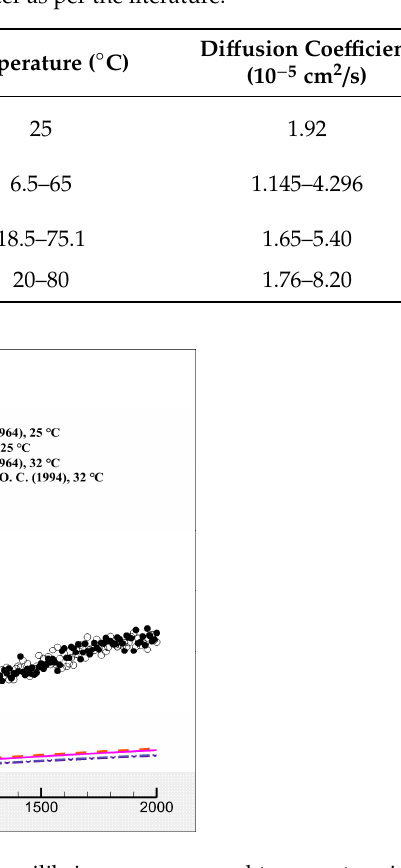
Table 4. CO 2 di ff usion coe ffi cients in water as per the literature.